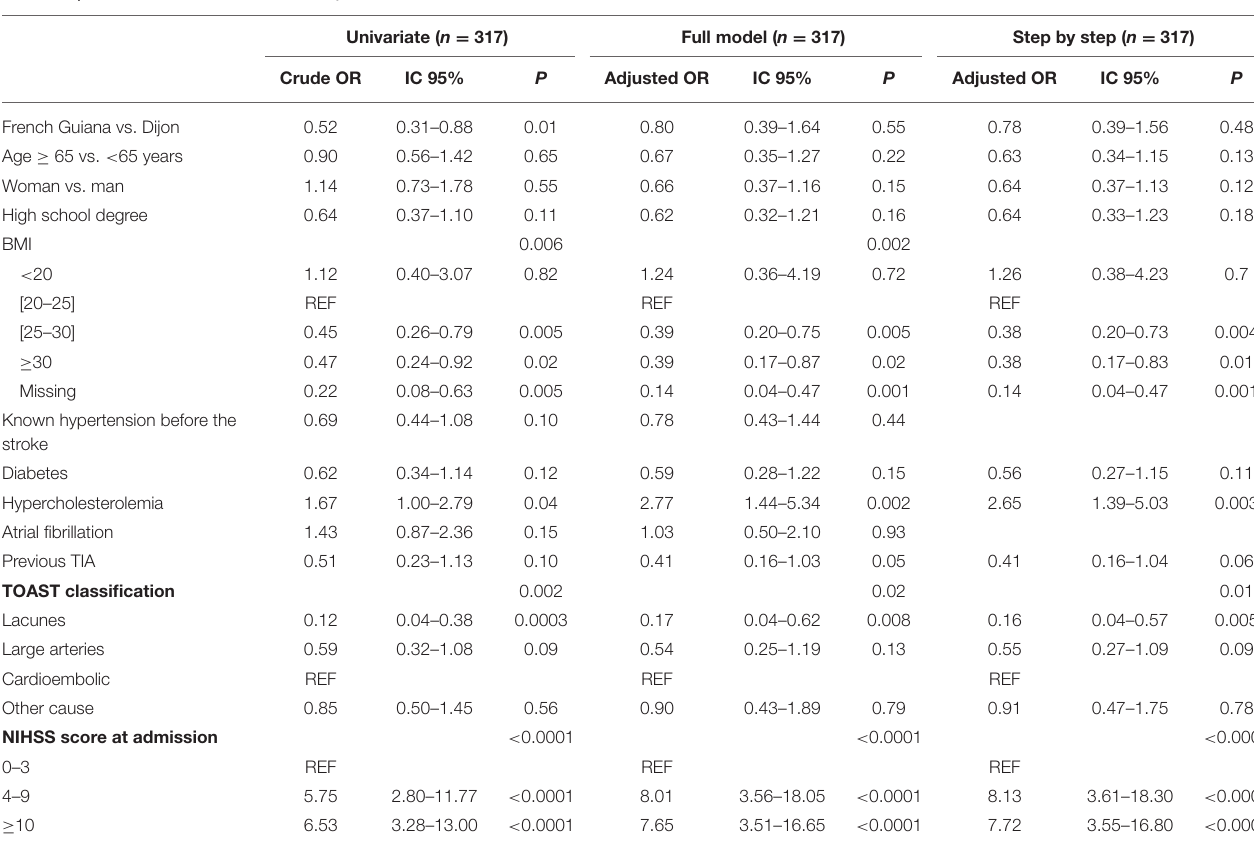
TABLE 2 | Factors associated with